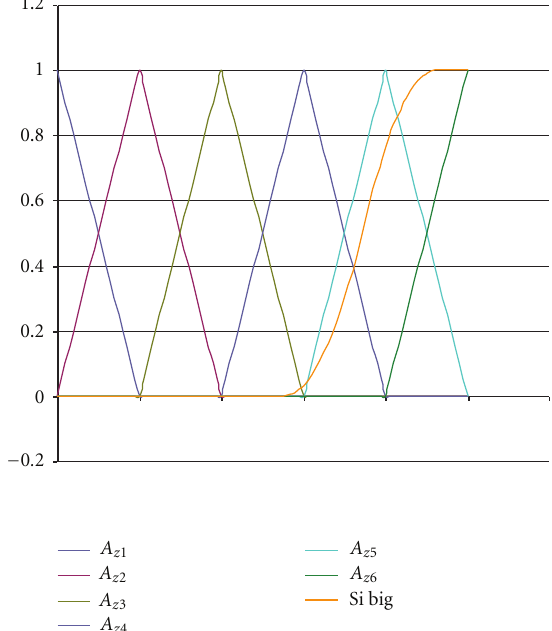
Figure 12: Inclusion areas for the fuzzy association rule R 1.